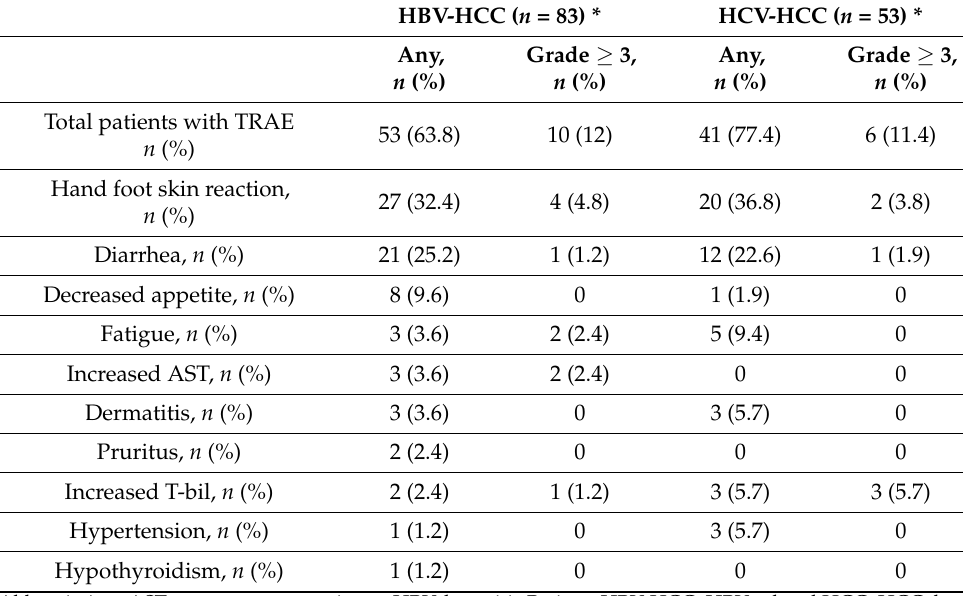
Table 3. Treatment-related adverse events (TRAE) in HBV-HCC and HCV-HCC